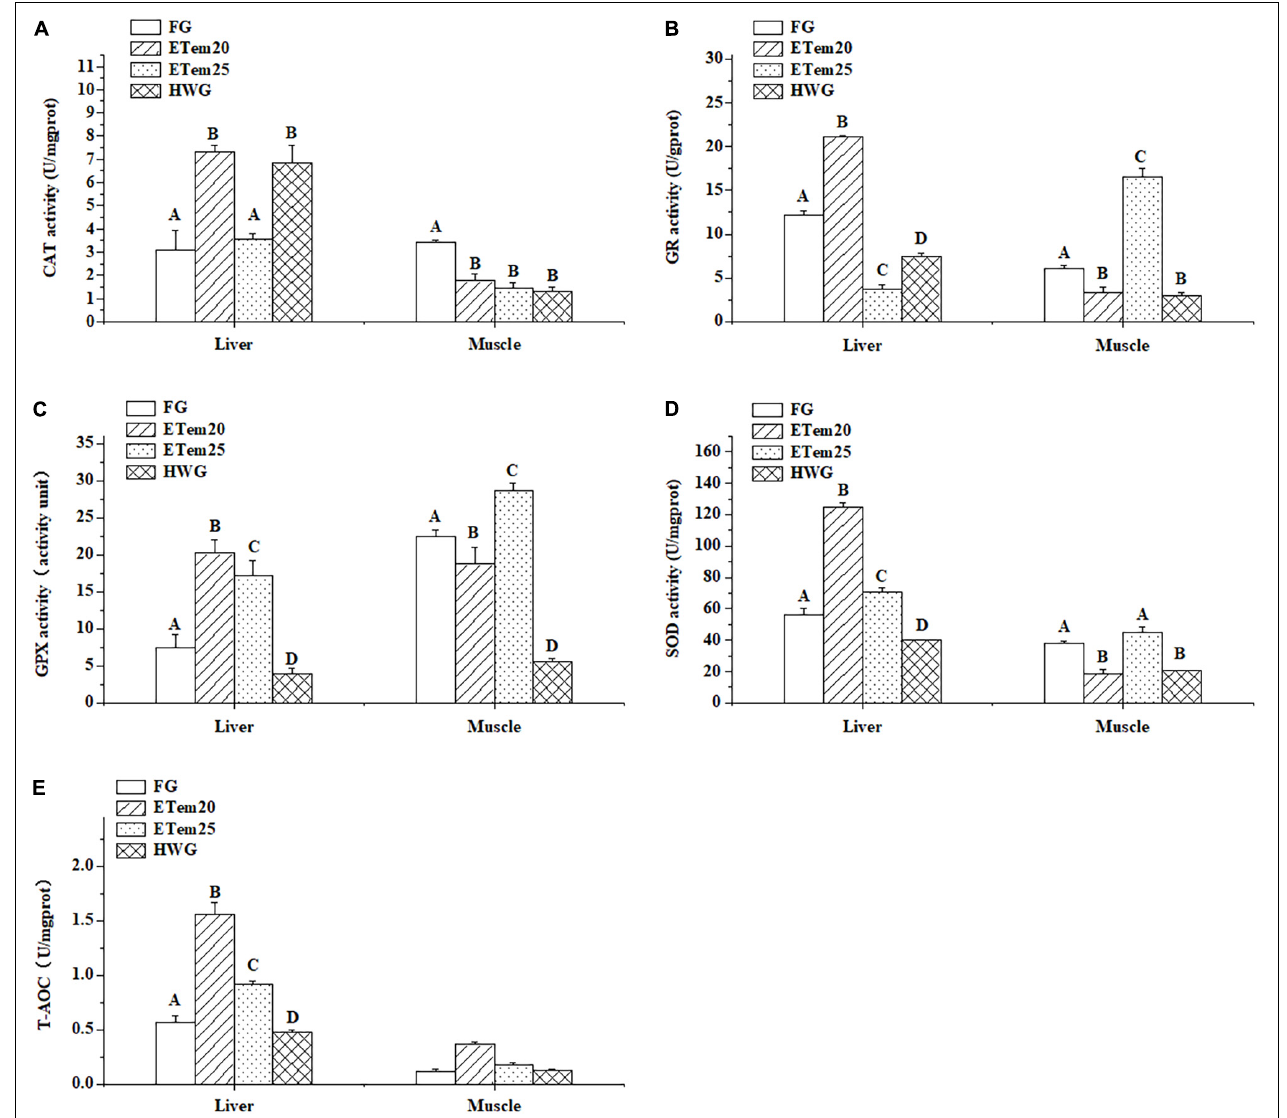
FIGURE 5 | Changes in panel (A) catalase (CAT), (B) glutathione reductase (GR), (C) glutathione peroxidase (GPX), and (D) superoxide dismutase (SOD) activity, and (E) total antioxidant capacity (T-AOC) in the liver and muscle of N. pleskei ( n = 8) in different temperature acclimation groups and field group. The sample size of each group was 8. The significant difference was shown by comparing all the groups. Different characters mean P <